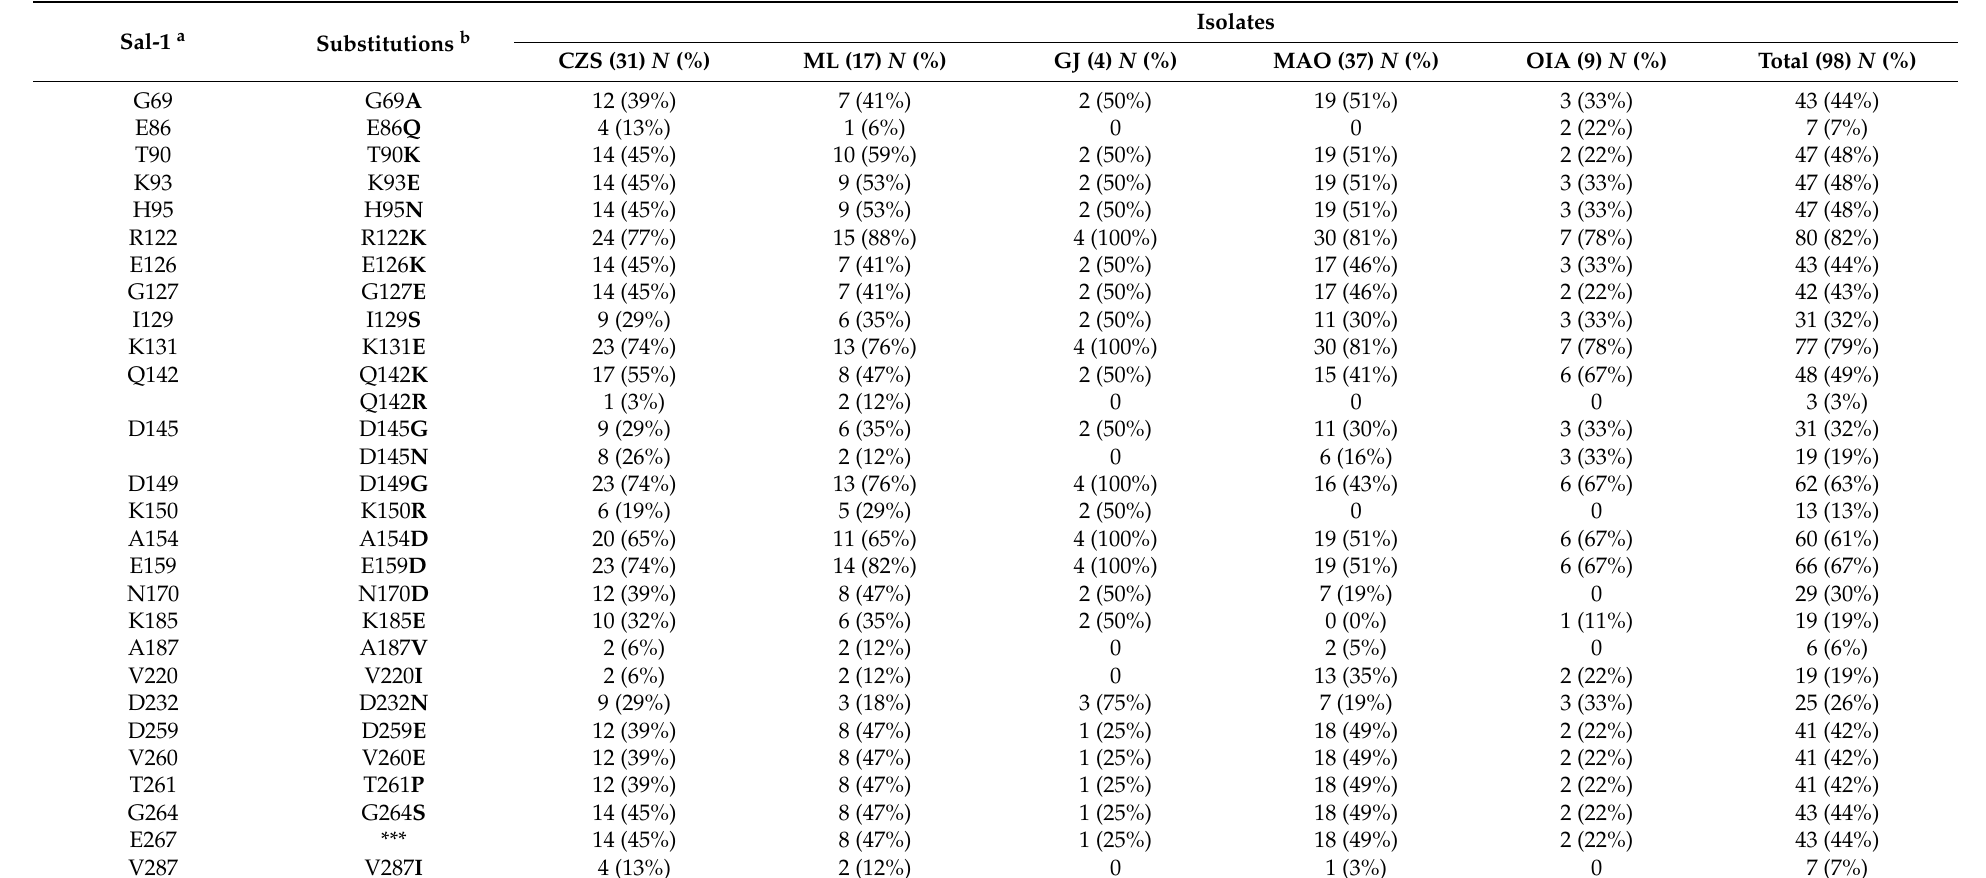
Table 2. Polymorphisms in the PvCyRPA of P. vivax isolates from the Brazilian